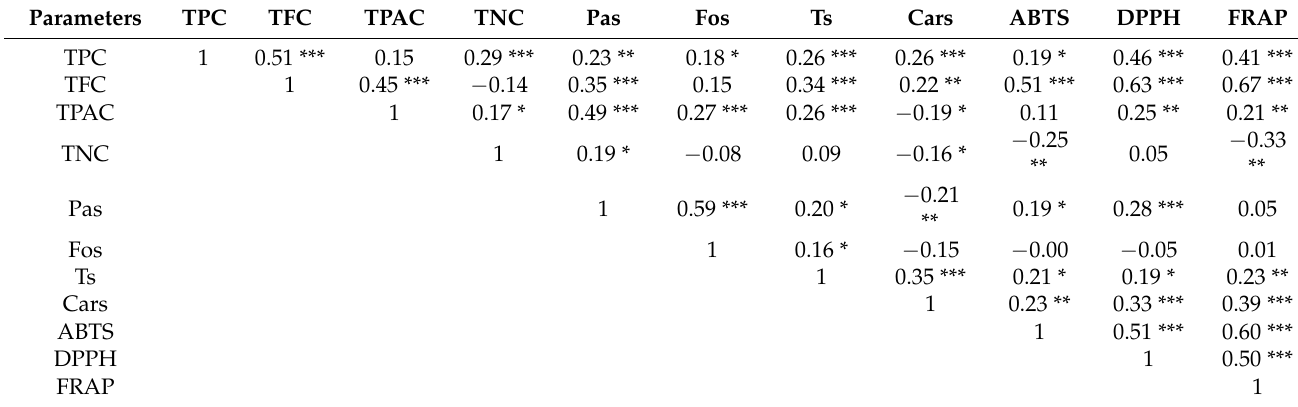
Table 4. Correlation coefficients (r) of all phytochemical components studied and antioxidant capacity of lentils genotypes across ten locations for two growing years in